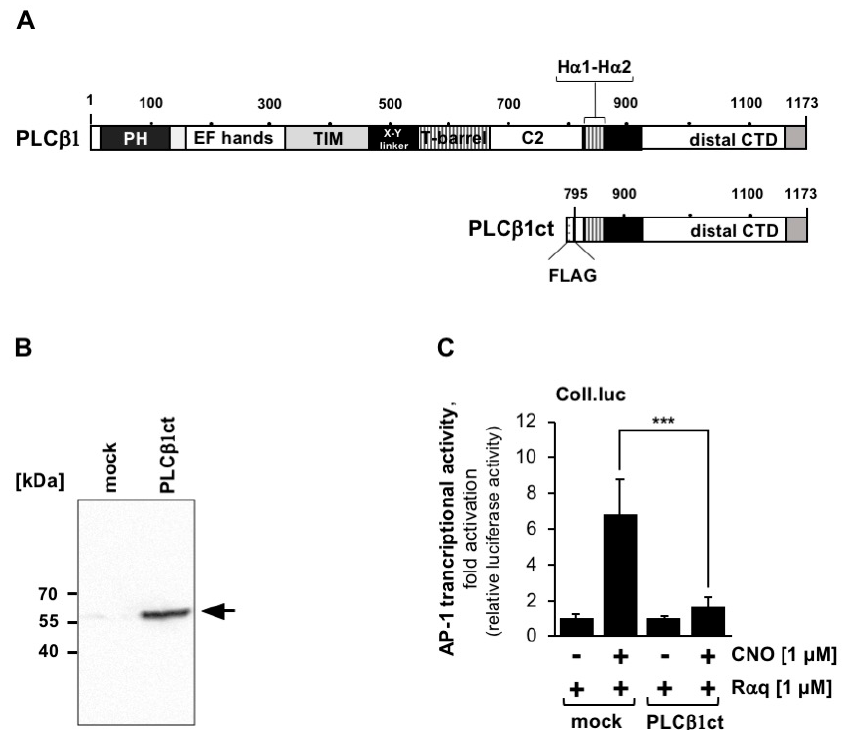
Figure 4. Expression of the C-terminal domain of phospholipase C β 1 blocks signaling R α q, a G α q- coupled designer receptor. ( A ) Multi-domain structure of phospholipase C β 1 and the truncated